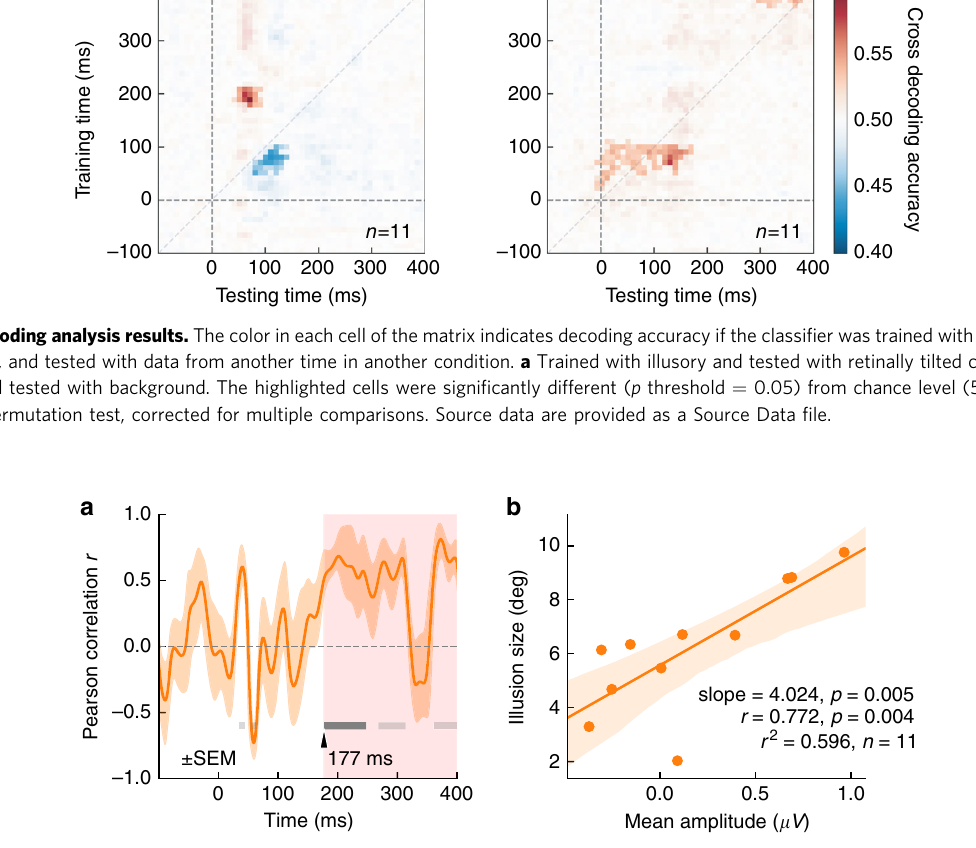
(Fig. 6a). Figure 6b, based on the same data as the shaded region in Fig. 6a, more explicitly shows the clear relationship between